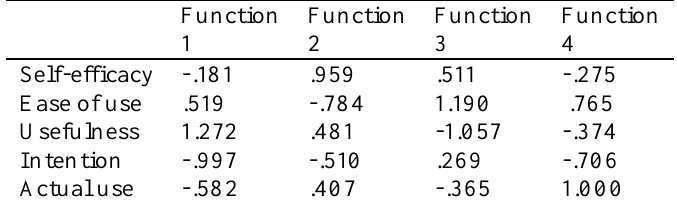
Standardized Canonical Discriminant Function Coefficients